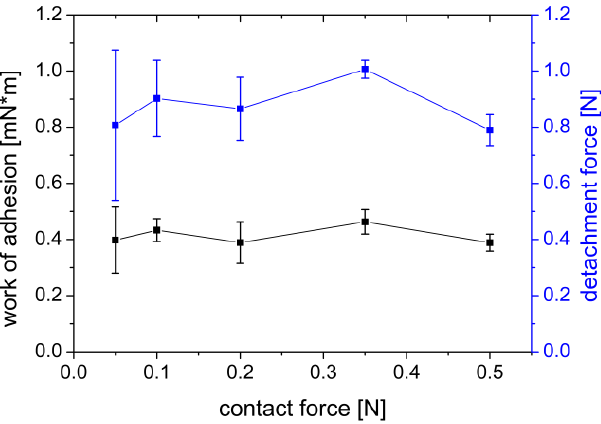
Figure 4. Effect of contact force of a PVA film on the work of adhesion (mN × m) and the detachment force (N) measured on a gel of 2% agar and 4% mucin. Mean ± SD, n = 6.